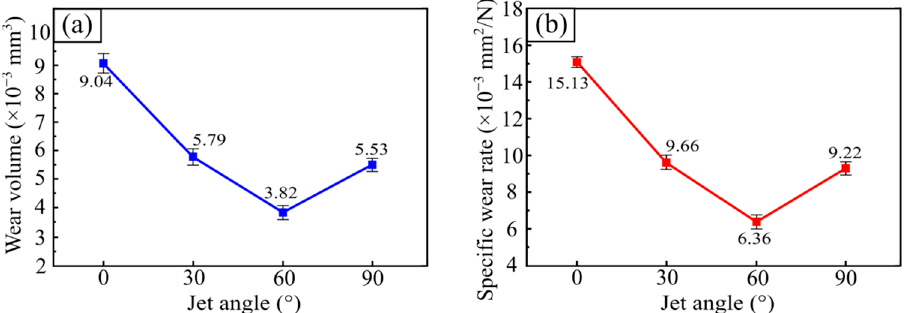
Figure 11. ( a ) The wear volume versus jet angle of SGP; ( b ) specific wear rates at different jet angles of SGP.